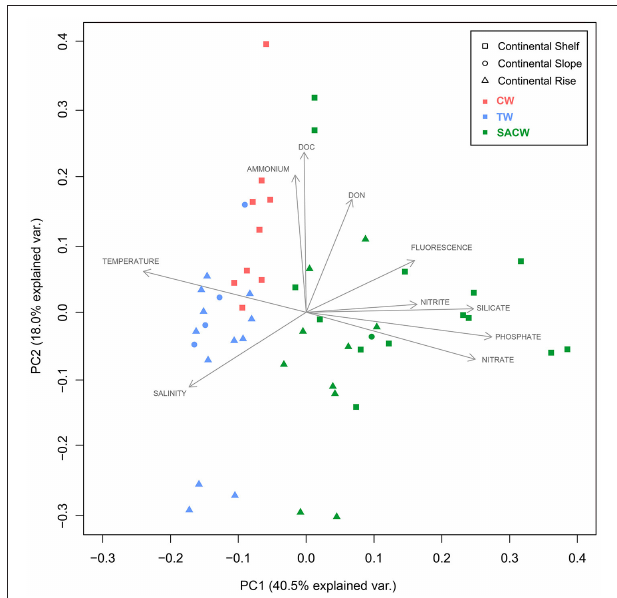
FIGURE 5 | Oceanographic-environmental scenario of the study area. Outcome of the principal component analysis (PCA): Plot of principle components PC1 and PC2 showing the distribution of environmental variables (temperature, salinity, fluorescence, phosphate, silicate, nitrite, nitrate, ammonia, dissolved organic carbon (DOC) dissolved organic nitrogen (DON). Squares represent samples collected on the continental shelf, circles represent samples collected on the continental slope, and triangles represent samples collected on the continental rise. Different colors represent the waters masses: Red is Coastal Water (CW), blue is Tropical Water (TW), and green is South Atlantic Central Water (SACW).